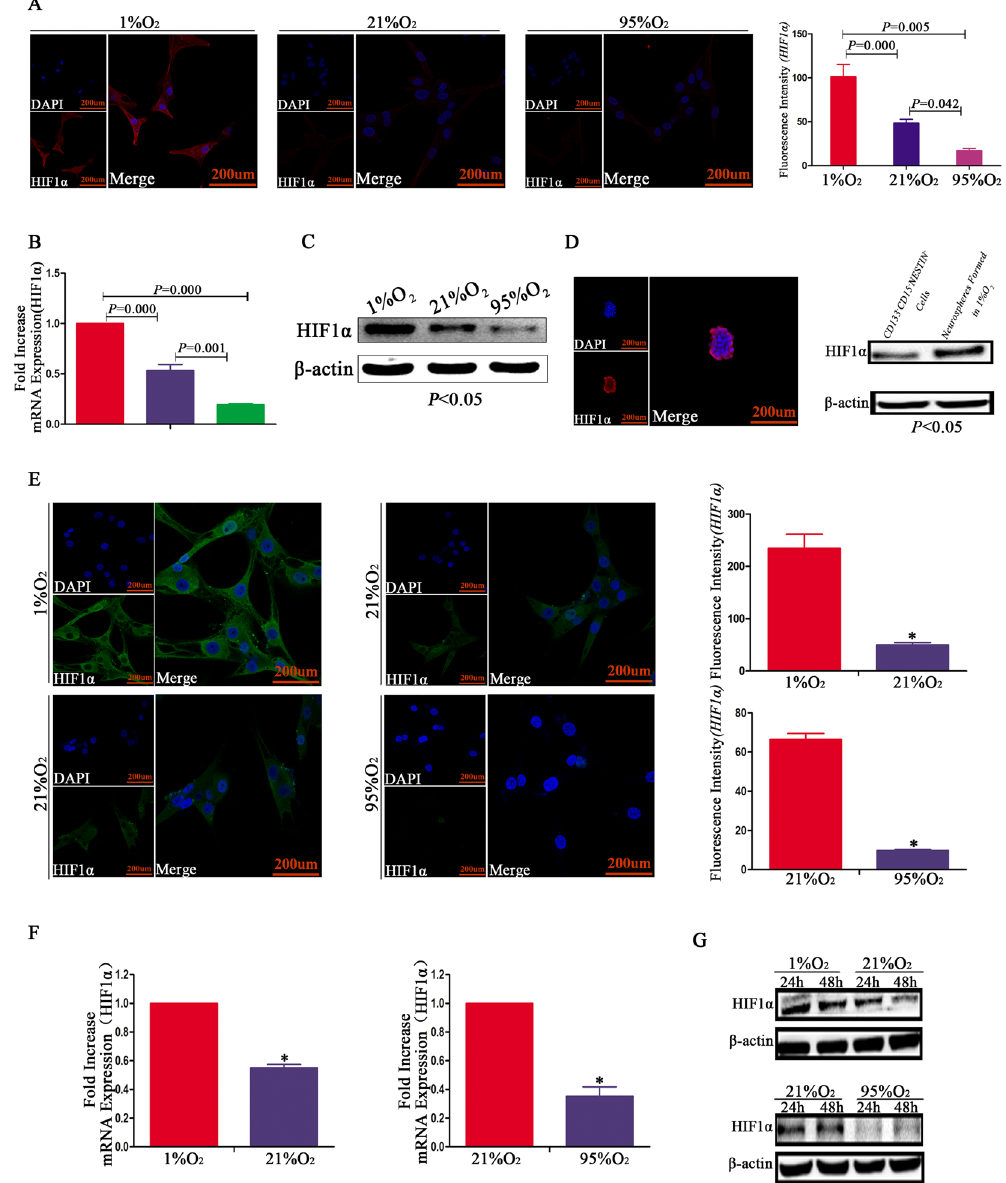
Figure 6. Higher levels of HIF1 α under hypoxic conditions, and hyperoxia inhibited HIF1 α expression. ( A ) An increased expression of HIF1 α for U87 CD133 − /CD15 − /NESTIN − cells in 1%O 2 conditions, which was predominately located in the cell cytoplasm; however, the HIF1 α levels significantly decreased after exposure in 21%O 2 or 95%O 2 ( P < 0.05, One-way ANOVA). ( B ) RT-qPCR indicated a 2-fold increase of HIF1 α mRNA levels for U87 CD133 − /CD15 − /NESTIN − cells in the 1%O 2 environment compared with normoxia; the expression of HIF1 α was the lowest after hyperoxia exposure ( P < 0.05, One-way ANOVA). ( C ) HIF1 α expression was the highest in 1%O 2 conditions, and the lowest levels of HIF1 α were identified for U87 CD133 − / CD15 − /NESTIN − cells in 95%O 2 . ( D ) GL261 neurospheres formed in 1%O 2 conditions highly expressed HIF1 α . ( E–G ) An enhancement of HIF1 α for newly formed U87 neurospheres in hypoxia was identified compared with normoxia and hyperoxia ( * P < 0.05, Paired-samples T